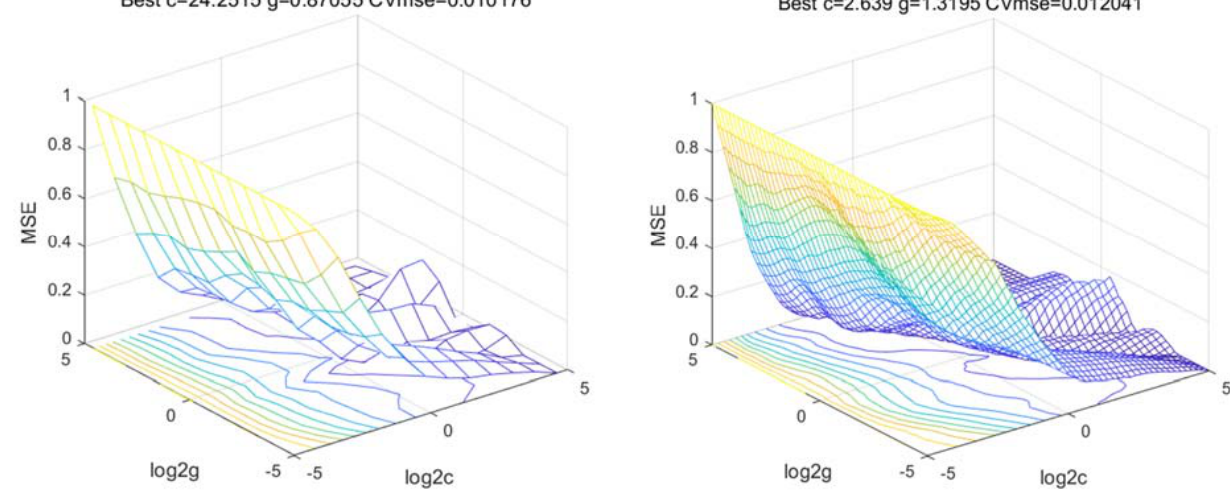
Figure 6. Search process for the best combination of hyper-parameters C and g .